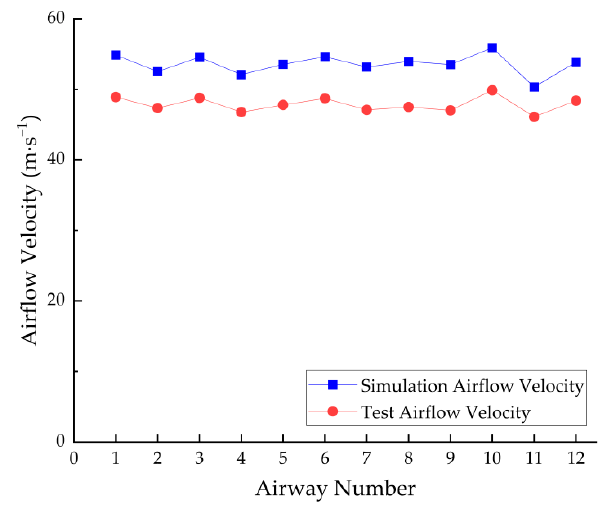
Figure 13. Dot–line graph of test results.